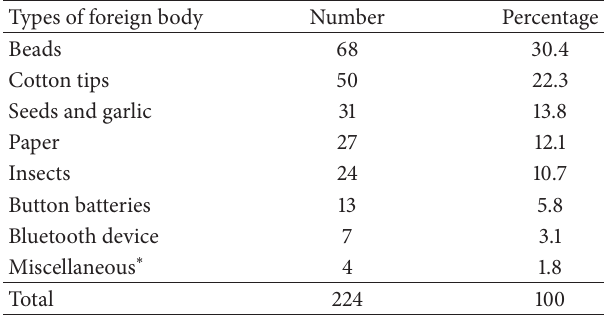
Table 2: Types of aural foreign bodies extracted from 224 patients.